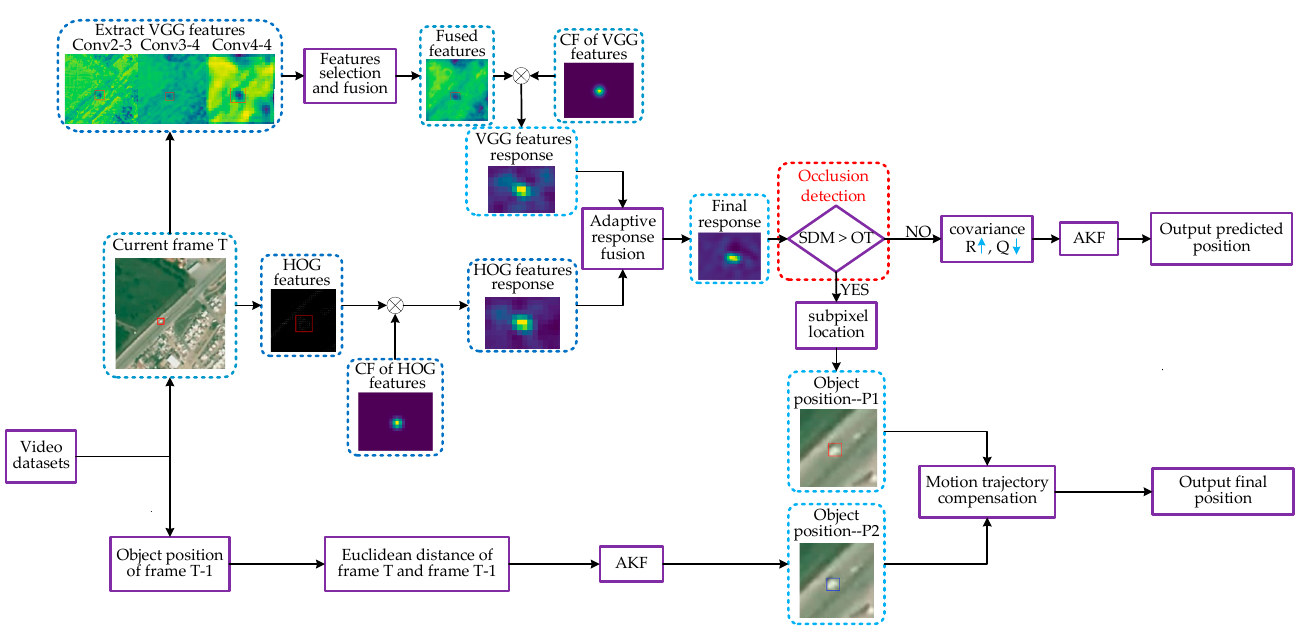
Figure 2. Flowchart of the proposed algorithm. CF and AKF are the abbreviations of correlation filter and adaptive Kalman filter. The Euclidean distance is the object center position of adjacent frames.